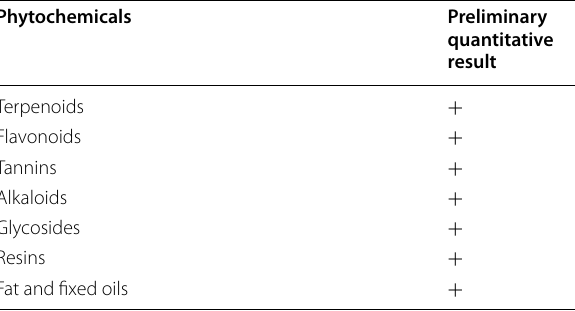
Table 1 Phytochemical analysis of methanolic extract of C.